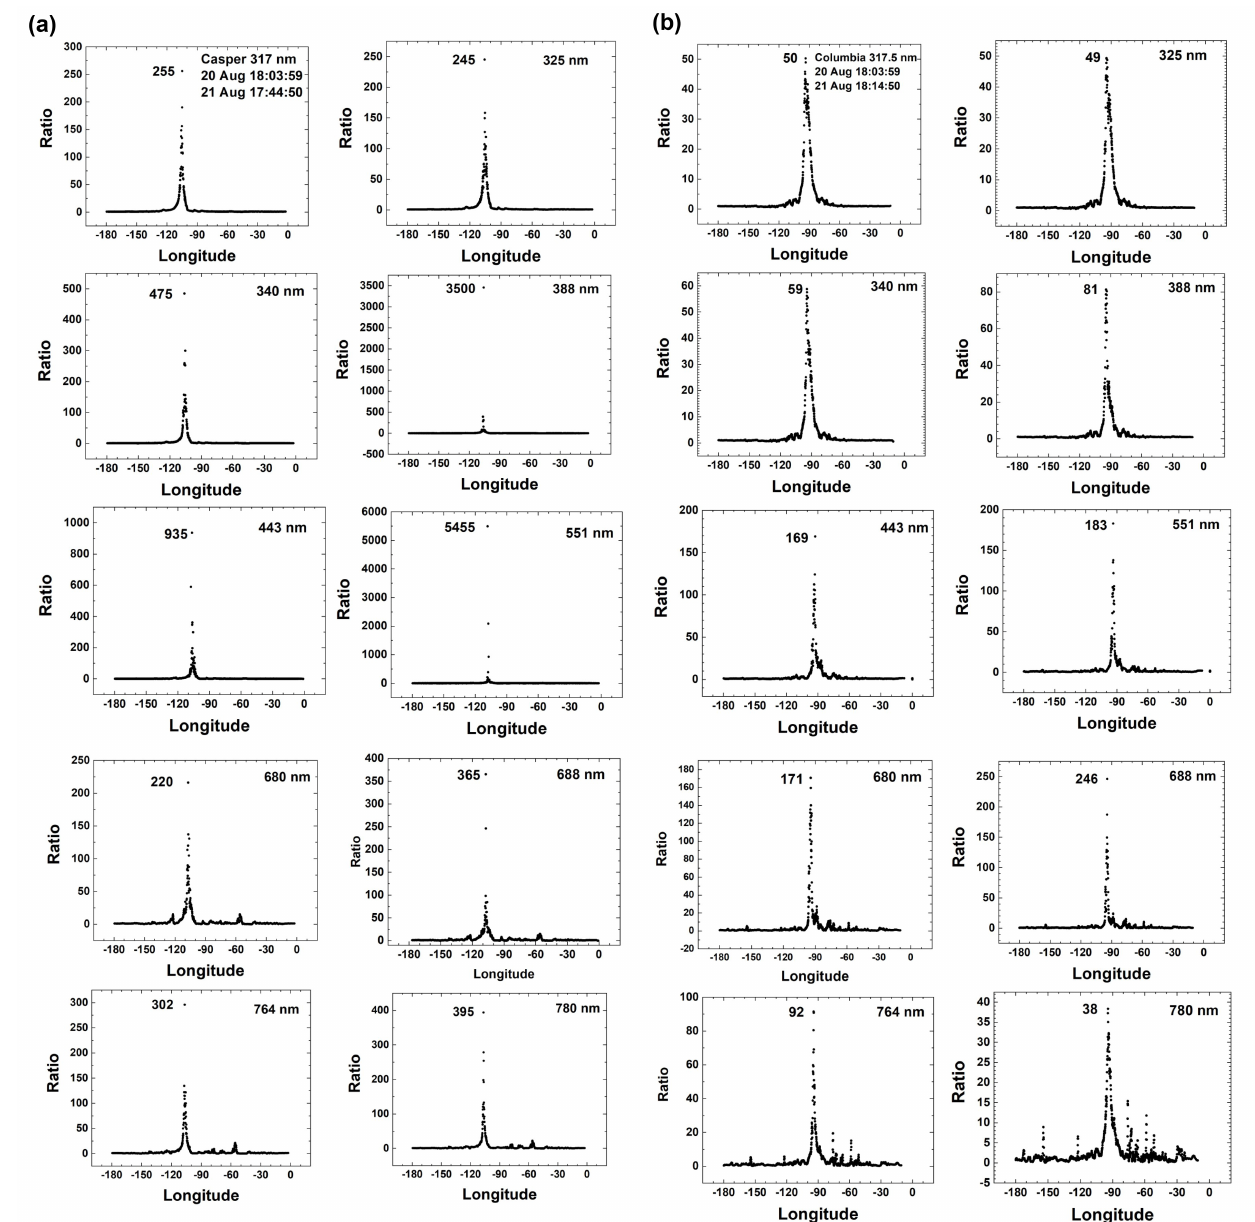
Figure 6. (a) The ratio R EN (λ i ) = I( 20 August )/I( 21 August ) at the time of the eclipse in Casper, Wyoming, for wavelengths 317.5 to 780nm. The channels 317.5 to 340nm are affected by ozone absorption, and the channels 688 and 764nm are within the O 2 B and A absorption bands. (b) The ratio R EN (λ i ) = I( 20 August )/I( 21 August ) at the time of the eclipse in Columbia, Missouri, for wavelengths 317.5 to 780nm. The channels 317.5 to 340nm are affected by ozone absorption, and the channels 688 and 764nm are within the O 2 B and A absorption